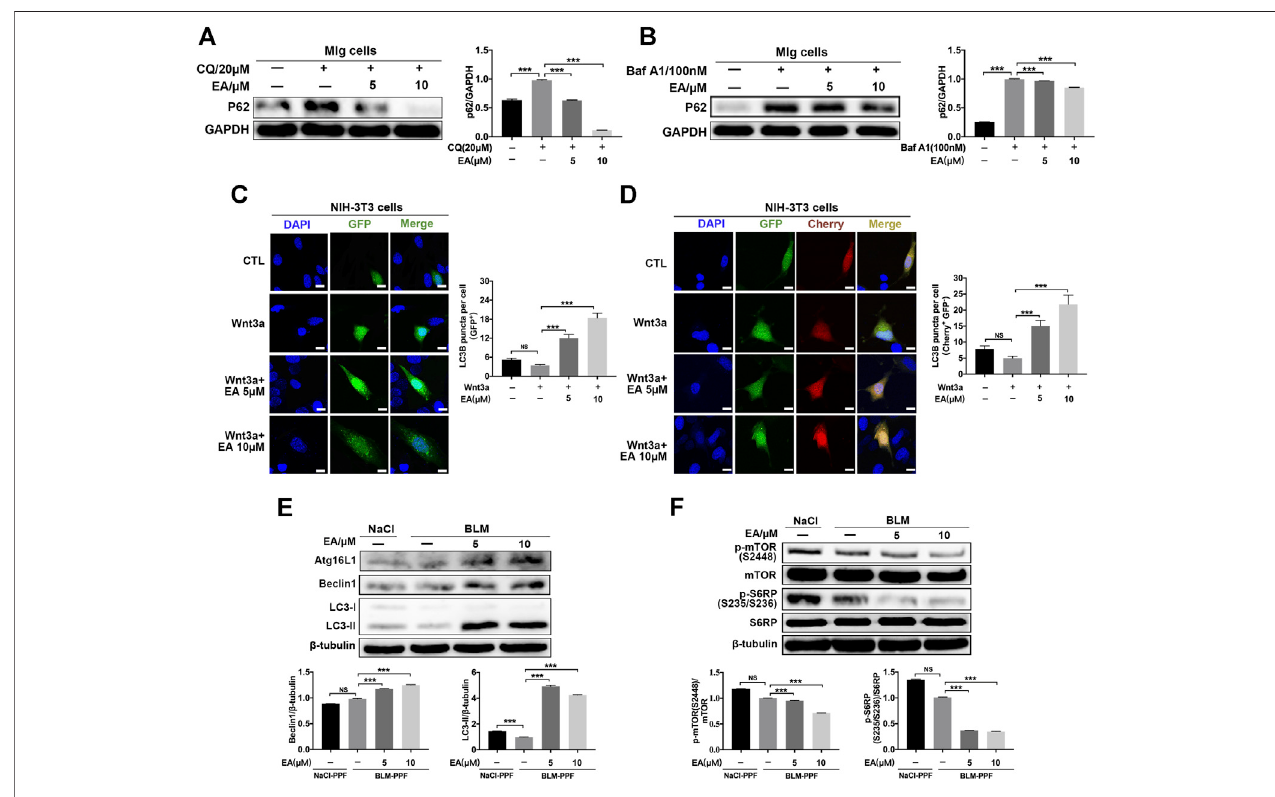
FIGURE 4 | Ellagic acid promotes pulmonary fi broblast autophagy mainly via inhibiting Wnt-mTOR signaling pathway (A , B) Mlg cells were exposed to CQ (20 µM) and Baf A1 (100 nM) with or without Ellagic acid (5 µM, 10 µM) to analyze the p62 expression level by using western blot. Densitometric analyses were shown beside (C , D) TheplasmidsofGFP-LC3BandmCherry-GFP-LC3Bweretransfected toNIH3T3cellswithPEI,andthesecellsweresubsequentlyexposedtoEllagicacid(5 µM, 10 µM) and/or Wnt3a (100 ng/ml) for 12 h. DNA was counterstained with DAPI (blue). Quantitative analyses are showed beside. Scale bars: 50 μ m (E) BLM-PPF cells were treated with Ellagic acid (5 µM, 10 µM) for 24 h, and the Atg16L1, Beclin1 and LC3-II/I expression levels were detected by Western blot. Densitometric analyses were shown below (F) BLM-PPF cells were treated with Ellagic acid (5 µM, 10 µM) for 12 h, and protein expression levels of mTOR, S6RP and their phosphorylation were detected by Western blot. Densitometric analyses were shown below. Data are means ± Standard Error of Mean, n (cid:1) 3, * p < 0.05, ** p < 0.01, *** p < 0.001, and NS: nonsigni fi cant (one-way ANOVA). β -tubulin or GAPDH were used as a loading